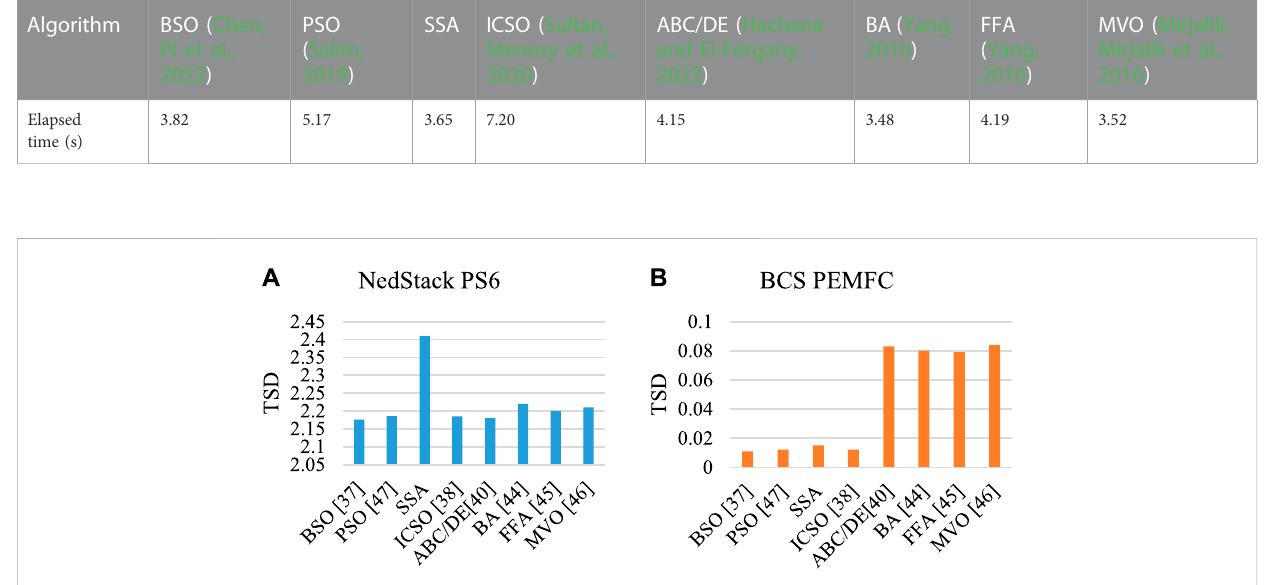
FIGURE 9 TSD bar plot of the two benchmarks, including (A) NedStackPS6 and (B) BCS PEMFC studied based on investigated swarm-based